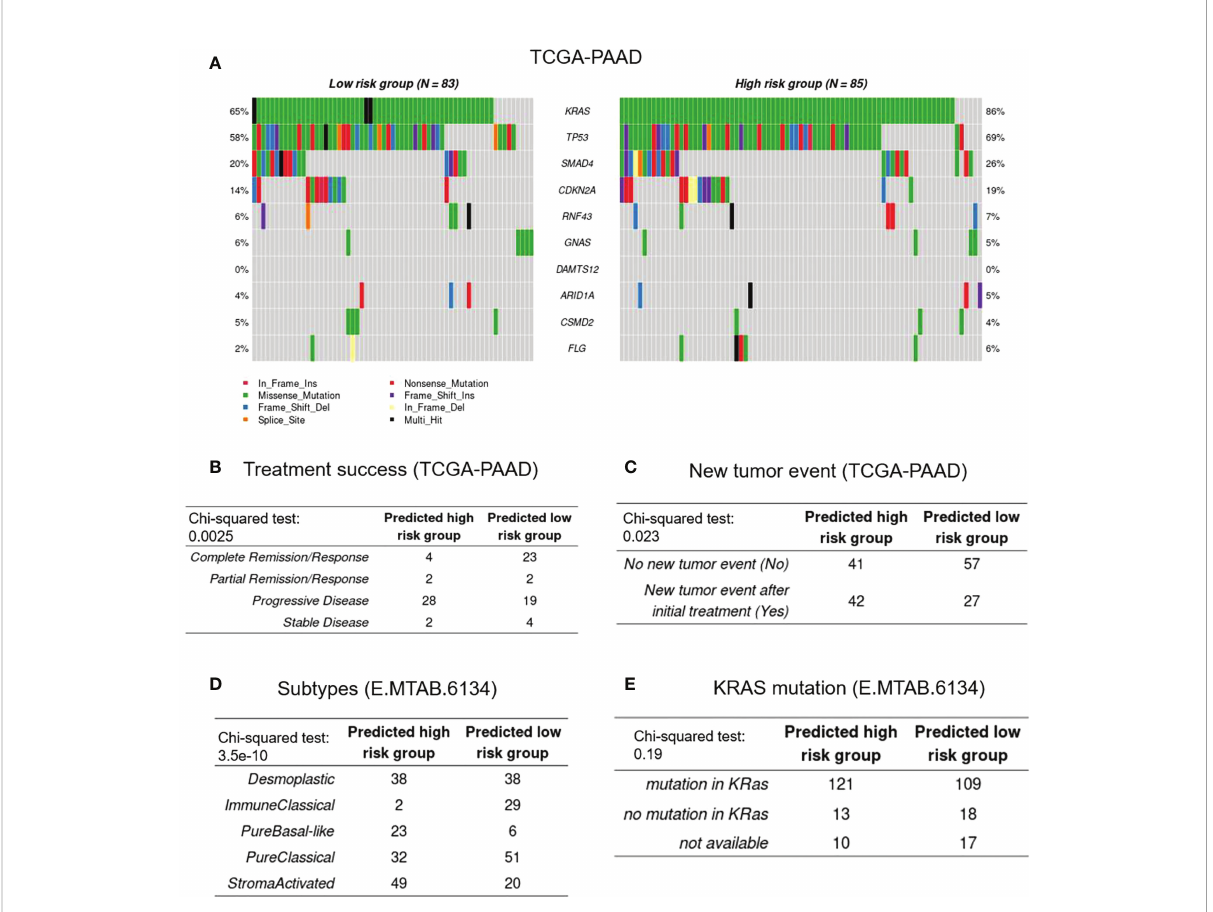
FIGURE 5 Genetic and clinical association with CAF-based signature. (A) , Represents the frequencies of mutated genes among the high- and low-risk groups. (B-E) , Represent treatment success, new tumor events, histopathological subtypes, and KRAS mutational status,